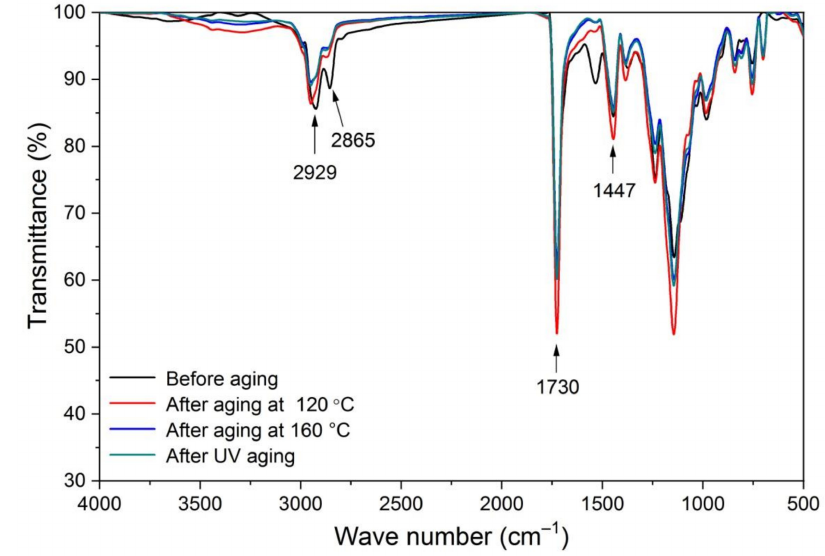
Figure 9. FTIR of the coating film without